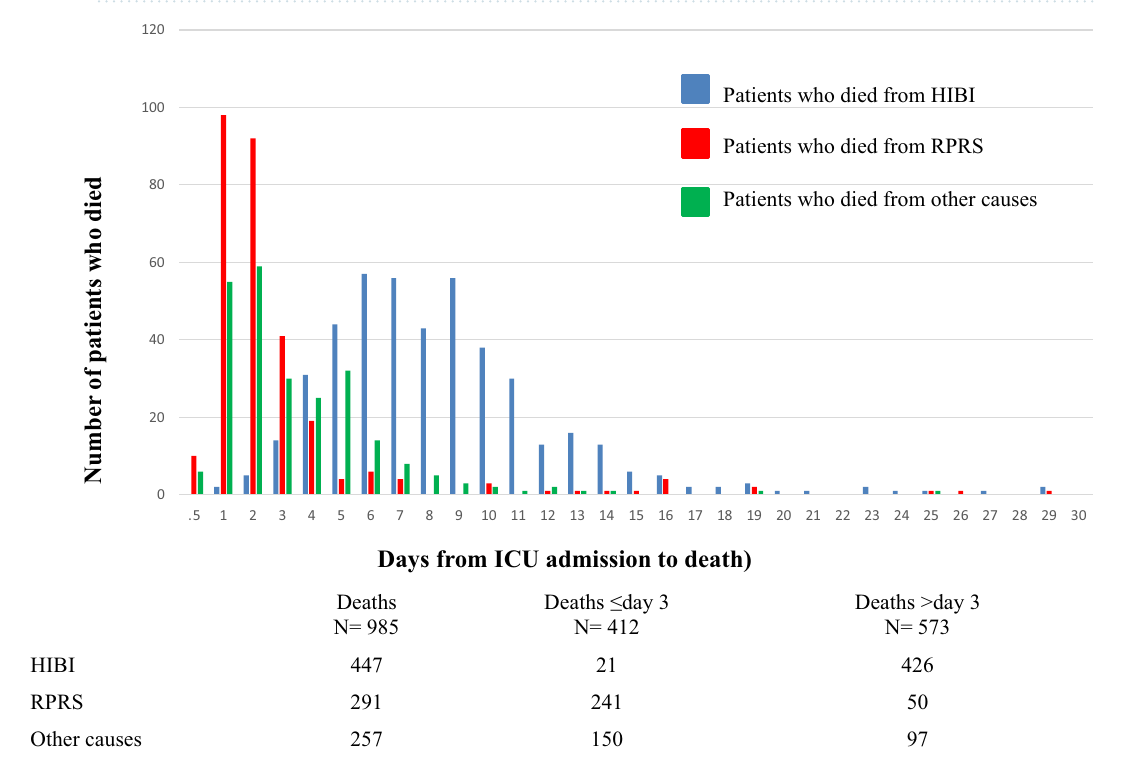
Figure 3. Reasons for death after out-of-hospital cardiac arrest over time in the intensive care unit. HIBI hypoxic-ischaemic brain injury, RPRS refractory post-resuscitation shock, ICU intensive care